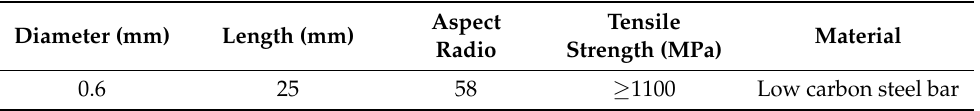
Table 6. Properties of steel fiber.